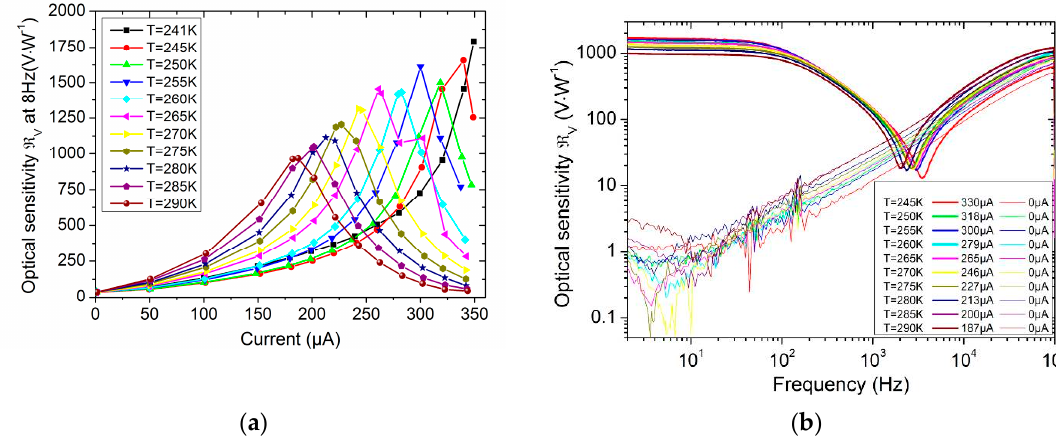
Figure 2. Optical characterization ( a ) Optical sensitivity as a function of the bias current for temperatures in the 240–290 K range; ( b ) Frequency response of the LSMO suspended bolometer measured at the optimal current for temperatures in the 245–290 K